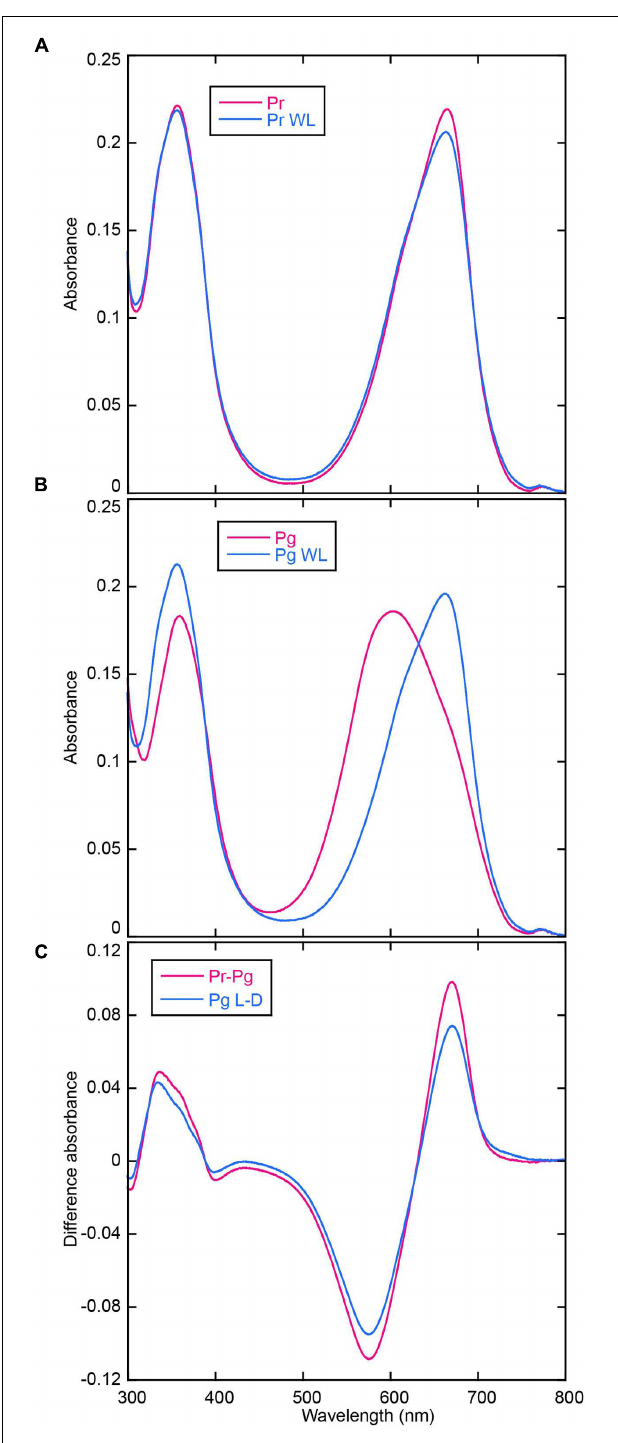
FIGURE 5 | Acid denaturation of AM1_C0023g2-PCB. (A) Absorption spectra of acid-denatured AM1_C0023g2-PCB Pr. Absorption spectra just after denaturation (Pr, magenta) and after white light illumination (Pr WL, blue). (B) Absorption spectra of acid-denatured AM1_C0023g2-PCB Pg. Absorption spectra just after denaturation (Pg, magenta) and after white light illumination (Pg WL, blue). (C) Pr-minus-Pg difference spectrum (Pr-Pg, magenta) and that during photoconversion of denatured Pg (Pg L-D,